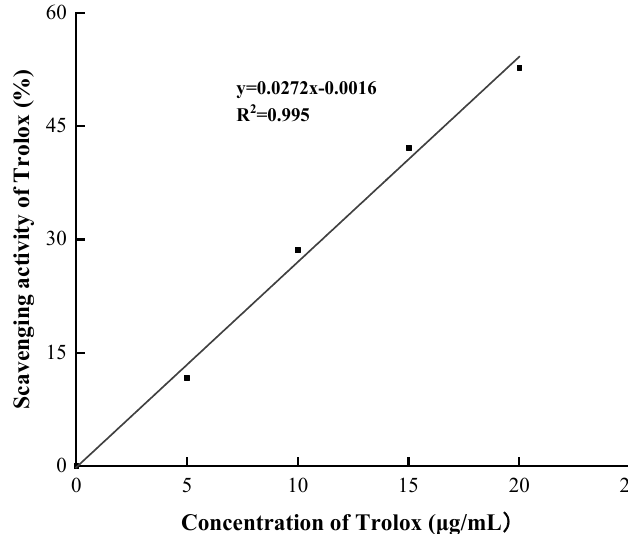
Figure 10. DPPH scavenging activity of standard Trolox.